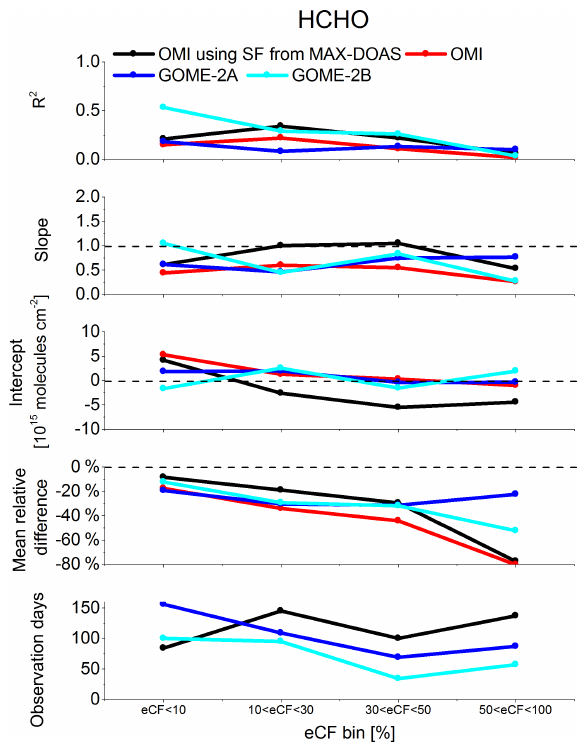
Figure 8. Same as Fig. 3 but for